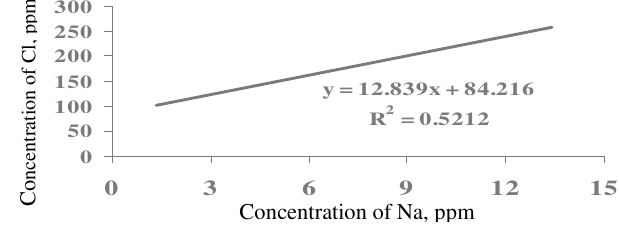
Figure 5 . Correlation between sodium and